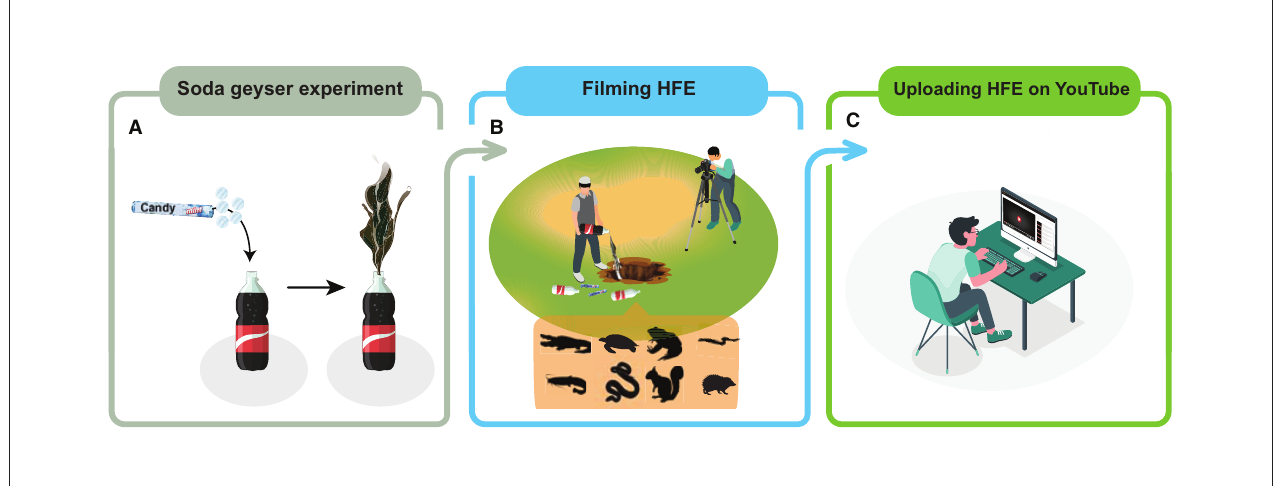
FIGURE 1 | Emergence of the so-called hunting–fishing–experiments (HFE). (A) Soda geyser experiment: before HFE, a popular content on YouTube was the Soda geyser experiment which consists of mixing soda with mint candy to provoke a chemical reaction that rapidly releases dissolved CO 2 from the soda. (B) Filming HFE: recently, people started using the soda geyser (with other products) to fish and hunt animals that use burrows while recording on film. (C) HFE content is typically edited in a documentary style then uploaded on YouTube.